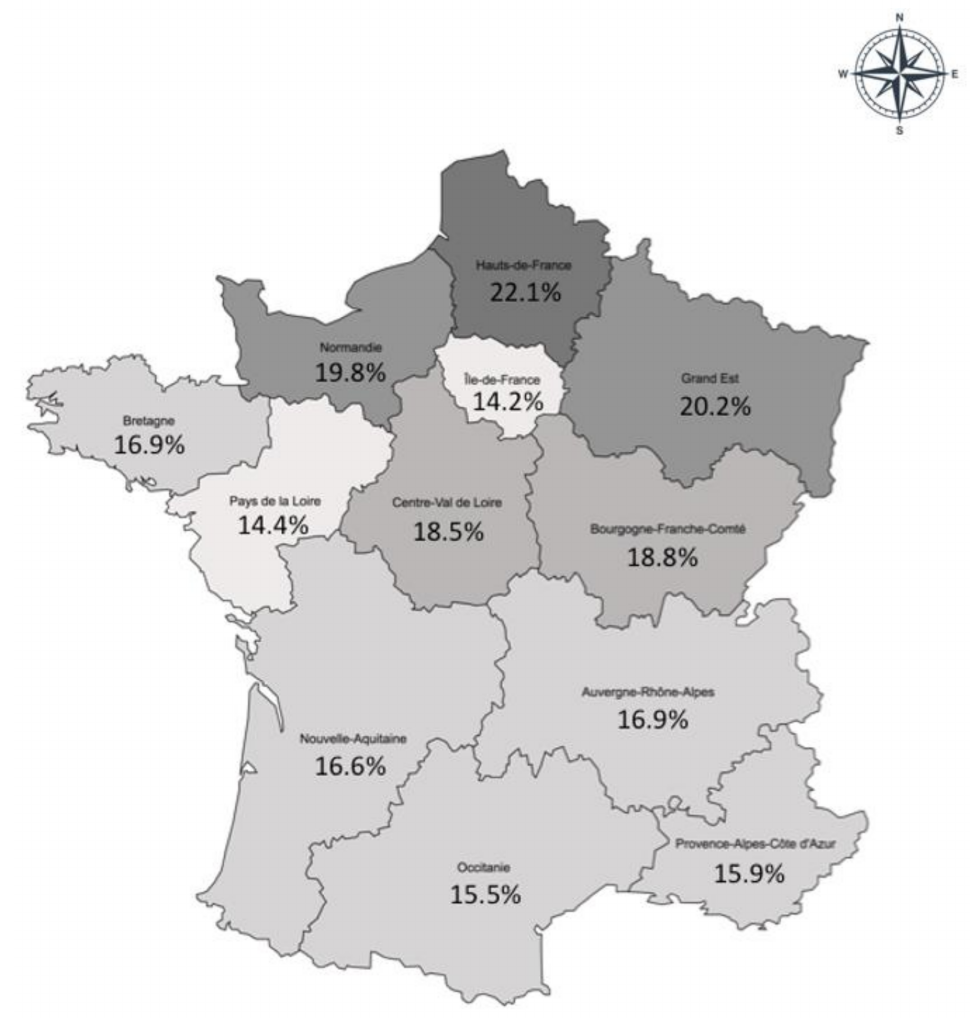
Figure 2. Regional distribution of the prevalence of obesity (BMI ≥ 30 kg/m 2 ), LCO 2020 Obepi- Roche